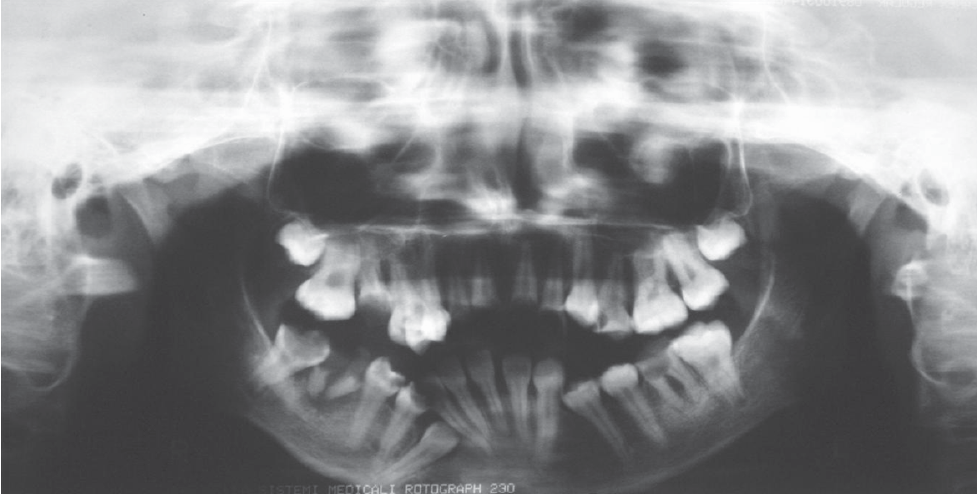
FIGURE 2- Panoramic radiograph showing the oral health